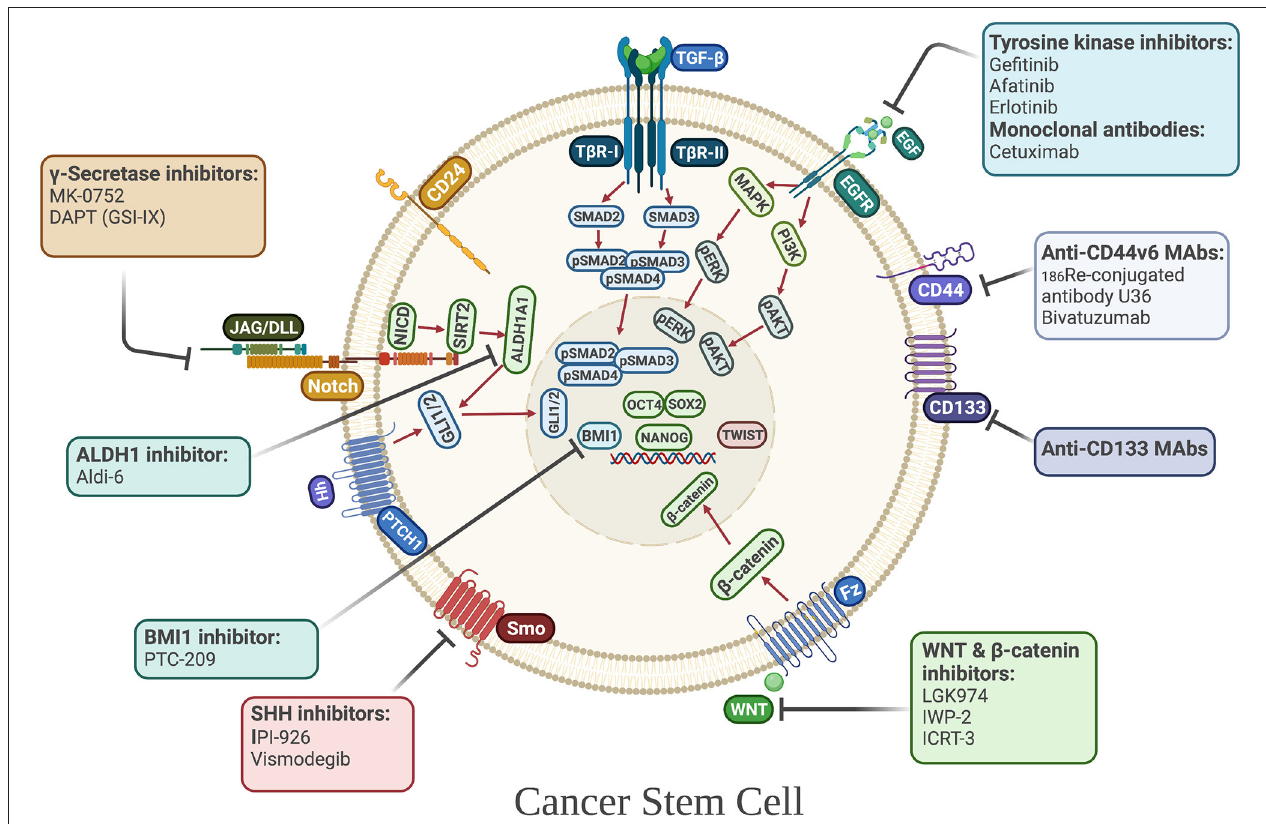
FIGURE 3 | Cancer stem cell-directed therapies in HNSCC. Selected anti-CSC drugs currently under clinical investigation. Their mechanisms of actions include targeting CSC-associated surface markers and CSC-associated signaling pathways, including developmental pathways, that regulate the maintenance, and survival of